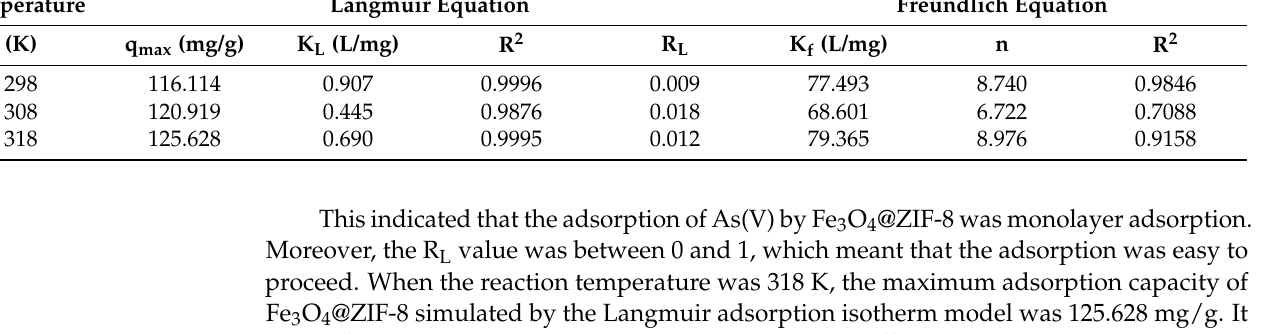
Table 1. The kinetic parameters for adsorbing As(V) by Fe 3 O 4 @ZIF-8. Temperature Langmuir Equation Freundlich